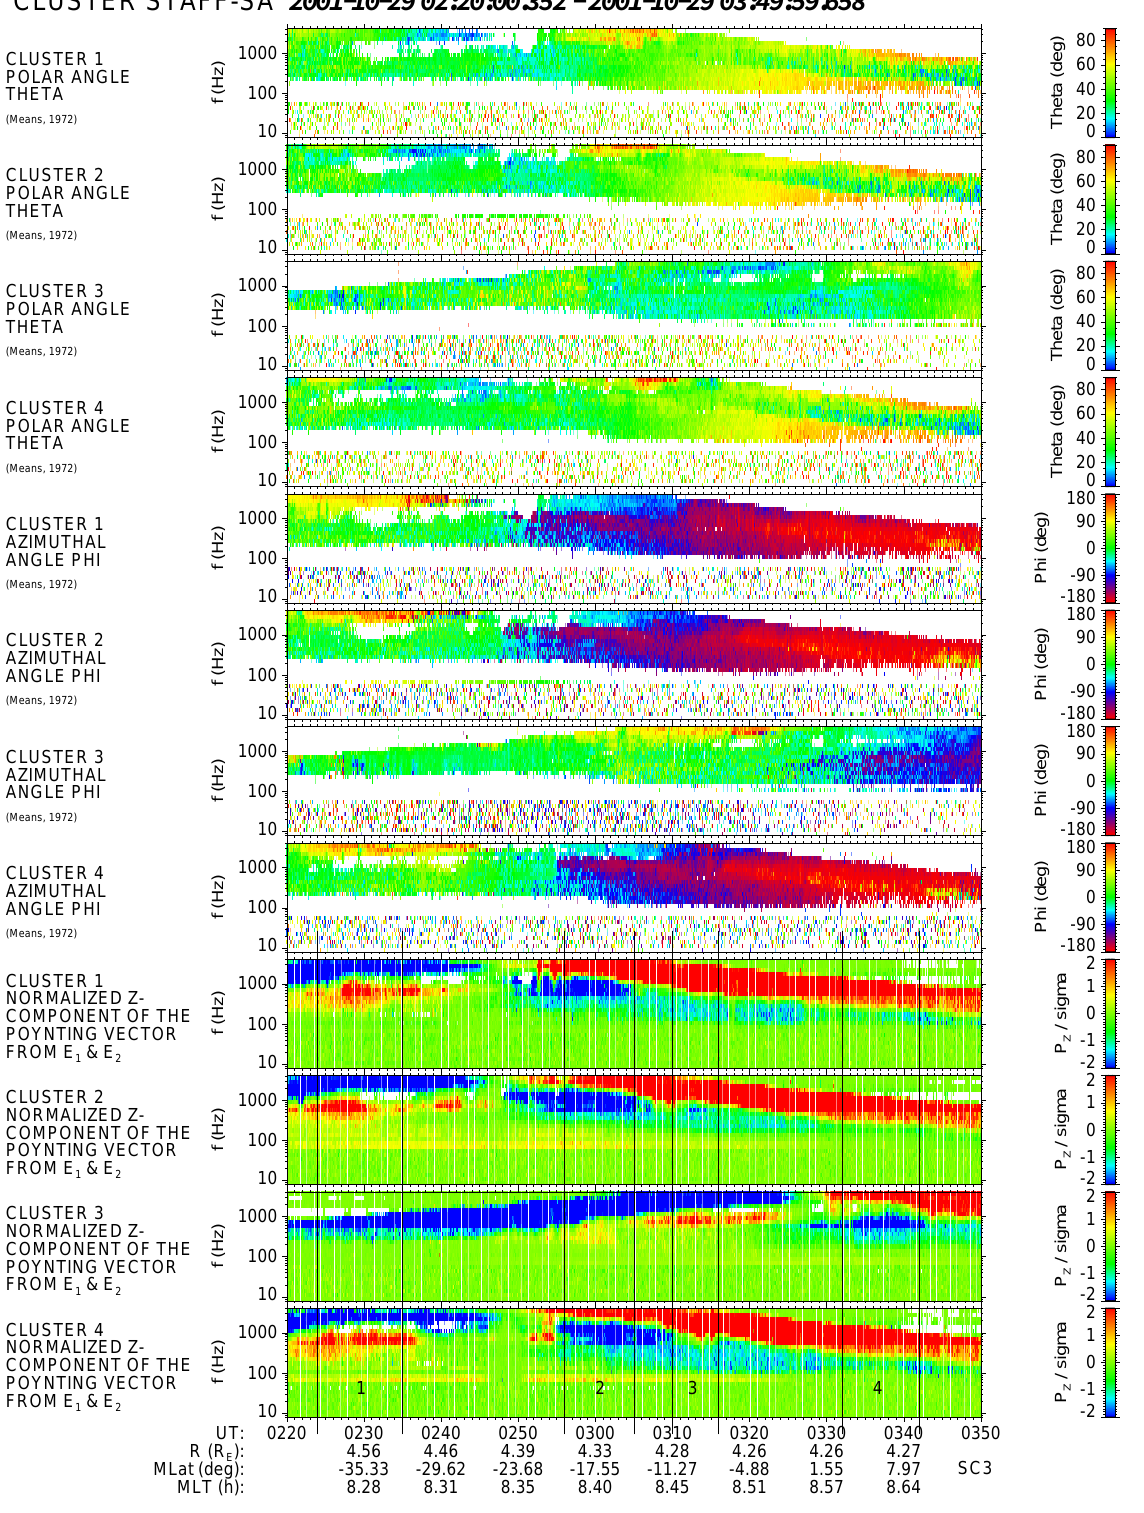
Fig. 2. Zoom of the event of Fig. 1 between 02:20 and 03:50UT. From the top to the bottom, the panels represent the polar angle θ and the azimuthal angle φ of the wave normal direction, and the direction of the z -component of the Poynting vector, for each SC, respectively. The values for the angles and the reliability of the sense of the Poynting vector are given by the colour-coded scales on the right. The geophysical parameters at the bottom are related to SC3. The vertical black lines delimit the four time intervals of detailed